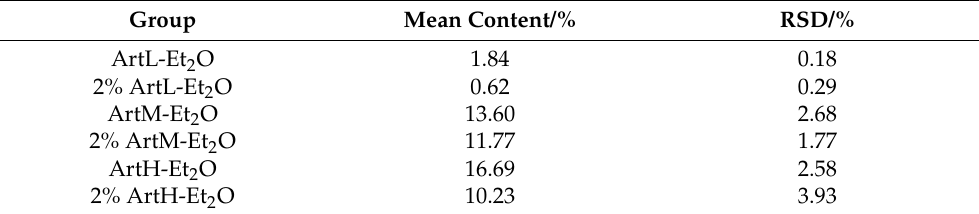
Table 1. Contents of artemisinin in different Artemisia annua L. samples. ( n = 3) . Group